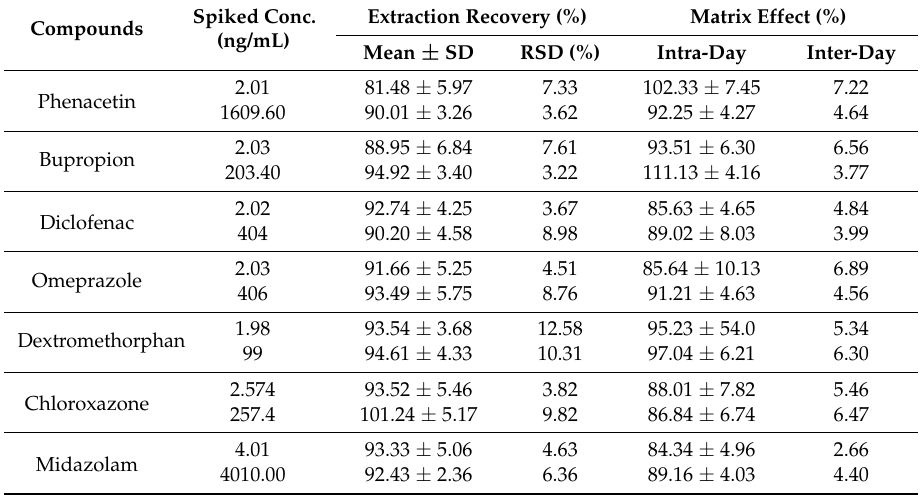
Table 3. The mean extraction recoveries and matrix effect of the seven analytes and IS in rats plasma at low and high concentration ( n =